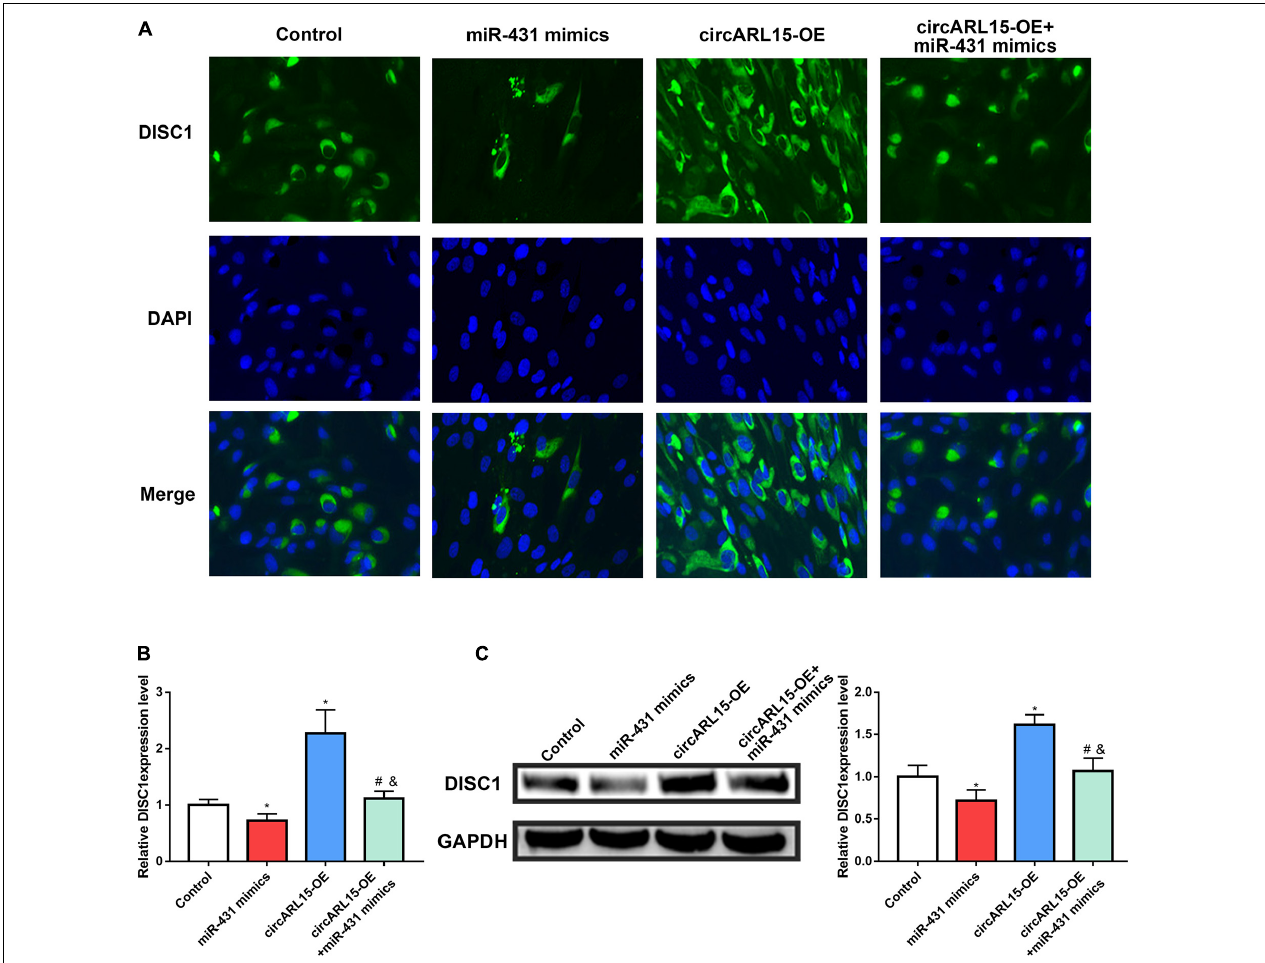
FIGURE 6 | circARL15 modulates the expression of DISC1 through miR-431-5p. NP cells were treated with negative control, circARL15 overexpression (OE) plasmid, miR-431-5p mimics and circARL15-OE + miR-431-5p mimics. (A,B) Immunofluorescence staining of DISC1. (C) DISC1 protein expression levels were analyzed by western blot analysis. * p < 0.05 compared with control; # p < 0.05 compared with miR-431-5p mimics. & p < 0.05 compared with